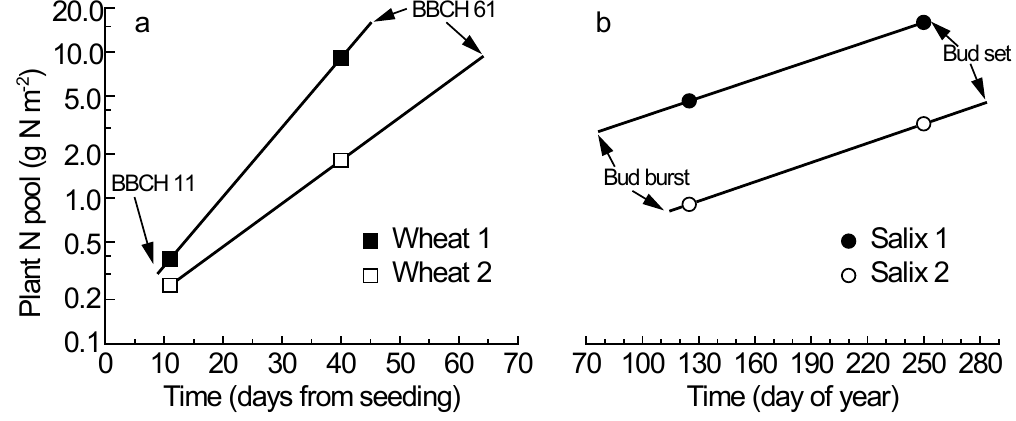
Table 1. The calculation of the mean N content during the main growth period ( N’ ) according to Equations (5)–(7) for two wheat and two Salix scenarios (scenario description see main text); shaded background indicates input variables, and light background indicates the calculated output; t = time (day after seeding in wheat, day of year in Salix ); N’ i and N’ f = initial and final plant N contents with respect to the main growth period; H1 and H2 = destructive harvest 1 and 2; R N = relative N accumulation rate during the main growth period; data from [9] for wheat and [13,14] for Salix .